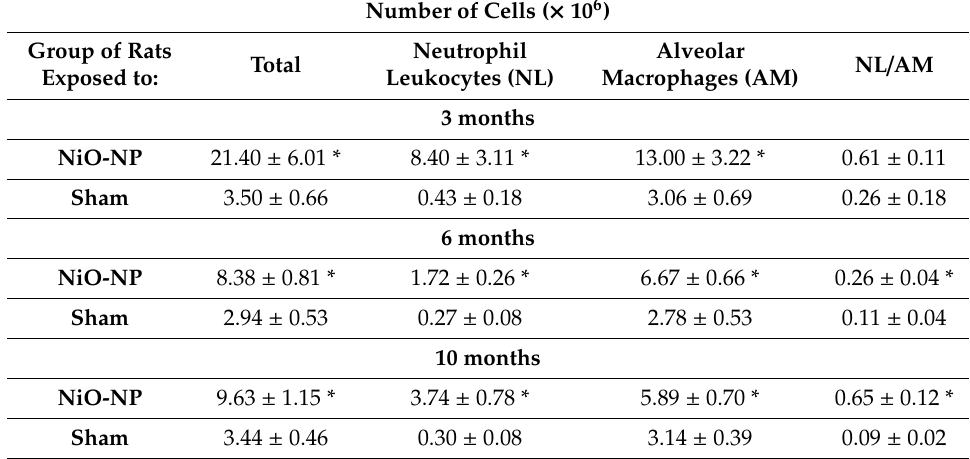
Table 4. Number of cells in the BALF obtained 24 h after the last 4 h inhalation exposure to the NiO-NPs at a 0.23 ± 0.01 mg / m 3 concentration repeated daily for 3, 6, or 10 months; mean results for at least 12 rats in exposed and sham-exposed groups of each term ( x ± s.e. ). Number of Cells ( × 10 6